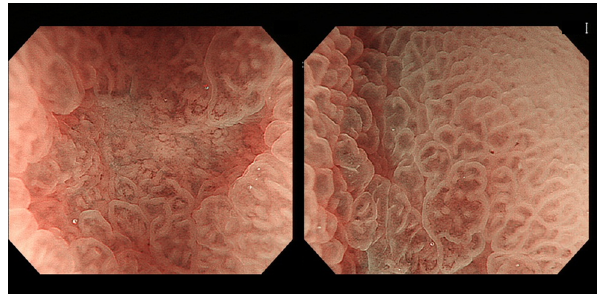
Figure 3. Non-cancerous lesion (gastritis): Absent DL, regular MVP, and regular MSP are noted.